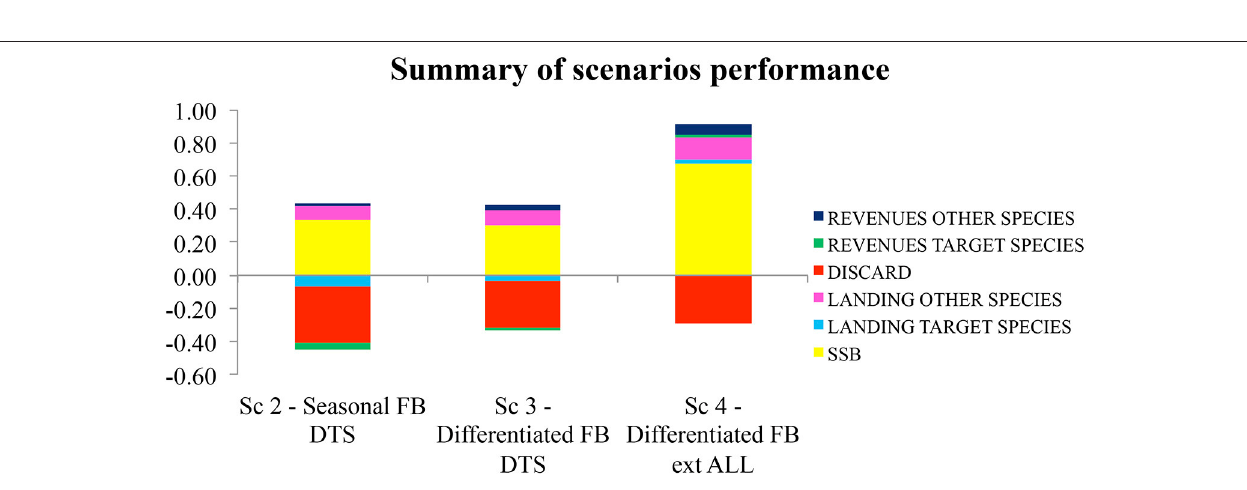
Frontiers in Marine Science |